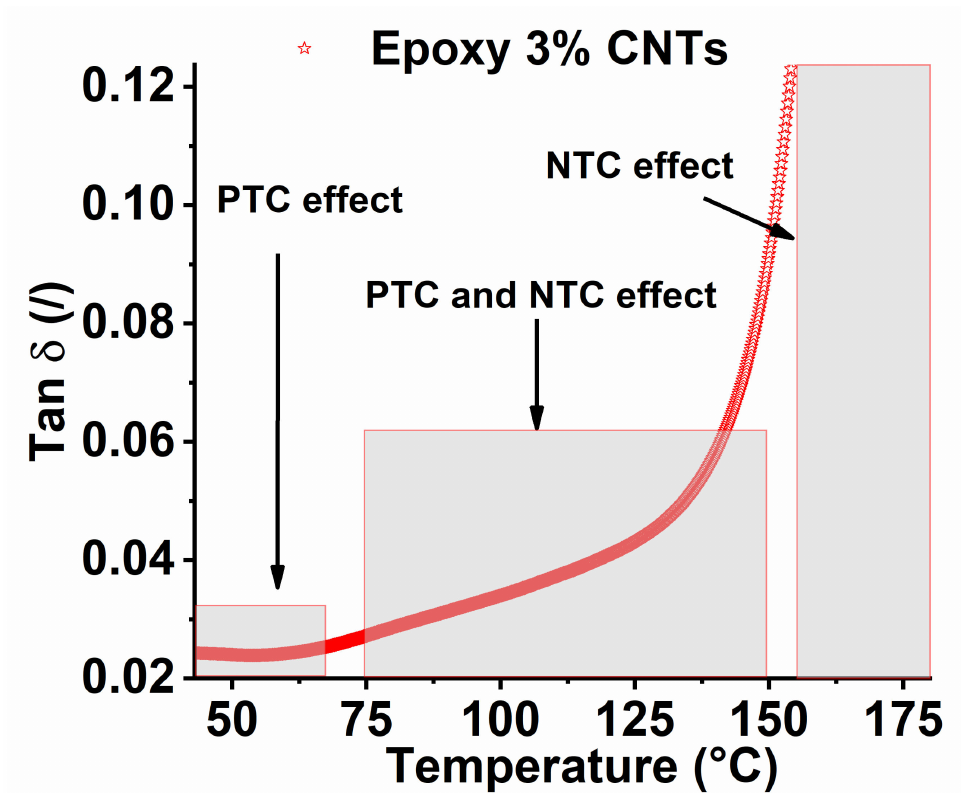
Figure 13. Loss factor (tan δ ) vs. the temperature in the region near the glass transition temperature.